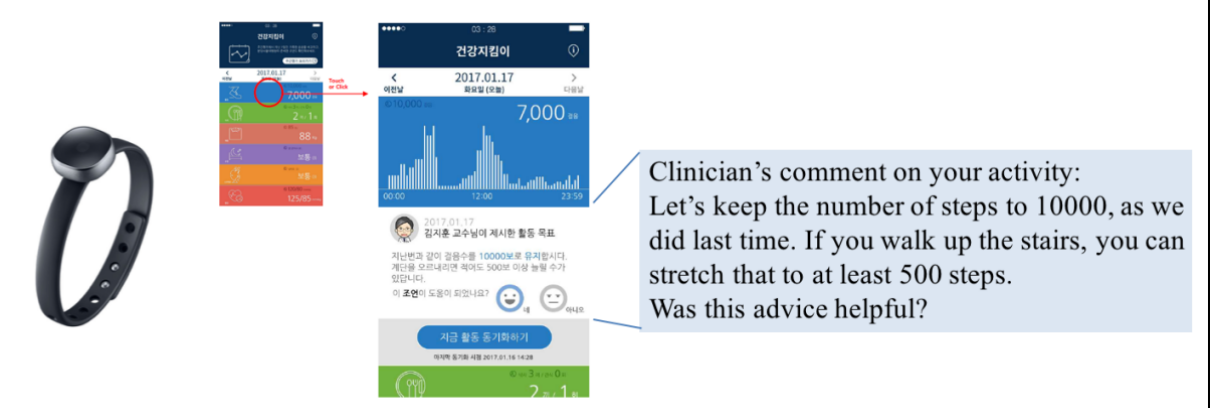
Figure 3. Clinician’s comment delivery on individual